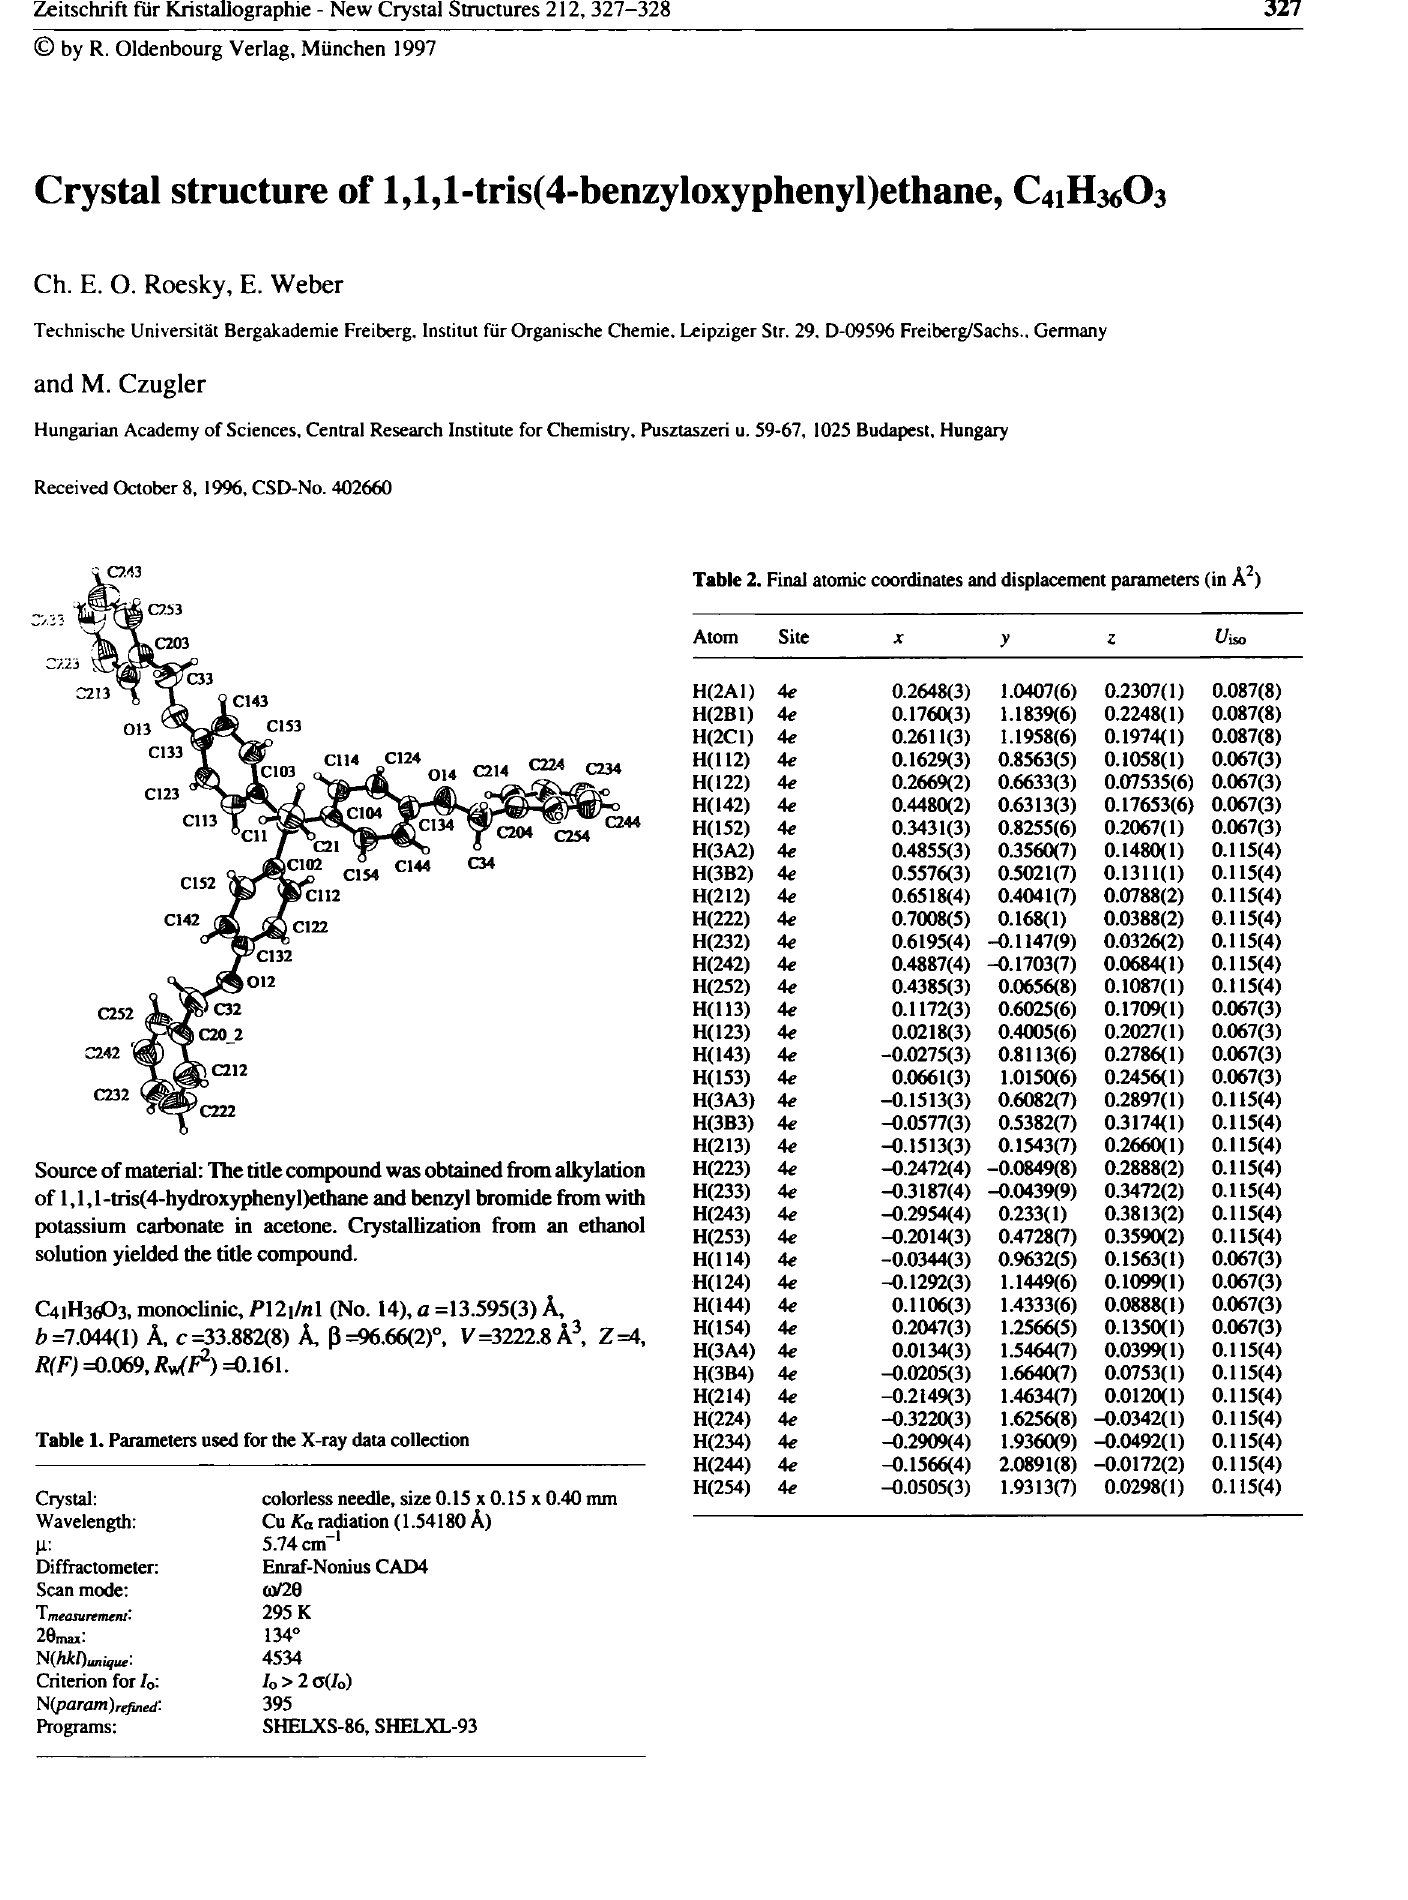
Table 1. Parameters used for the X-ray data collection